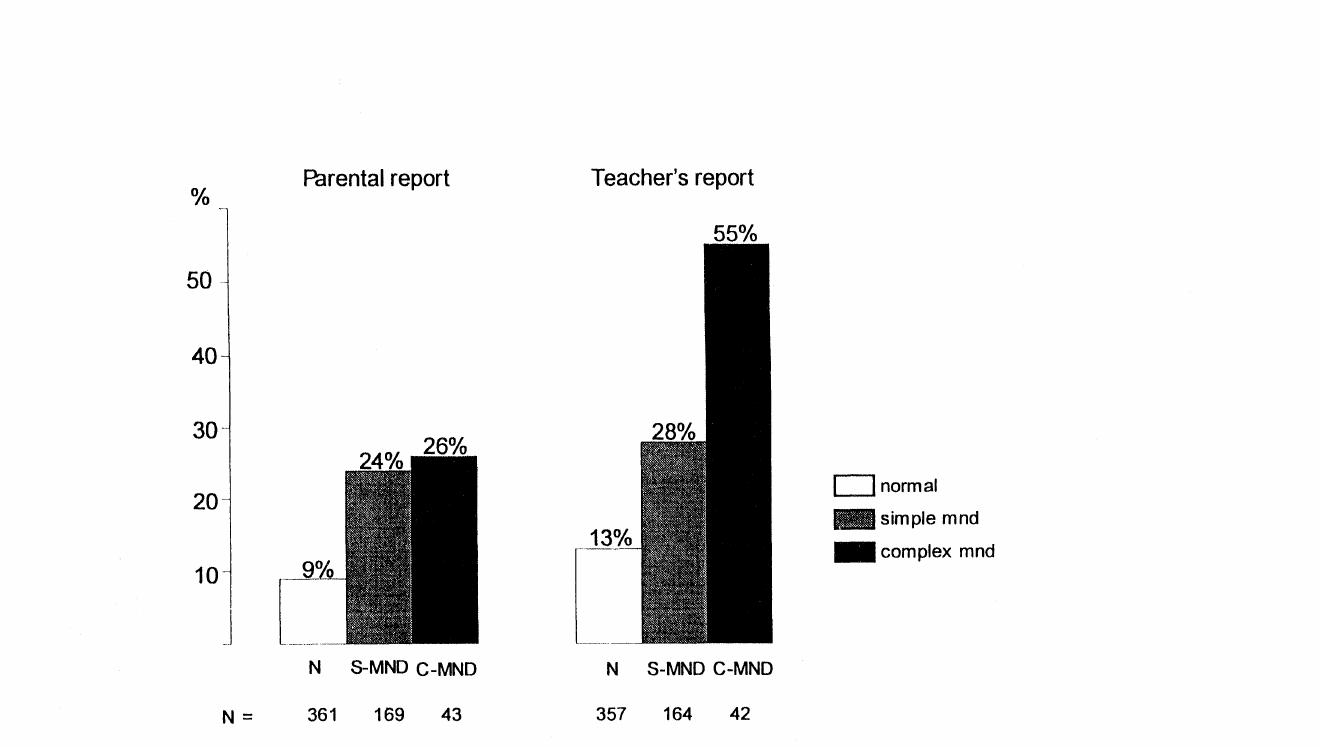
Fig. 1. Data of the Groningen Perinatal Project: relationship between neurological condition and clumsiness reported by parents (left panel) and teachers (right panel) in a group of nine-year-old children (see Hadders-Algra et al.